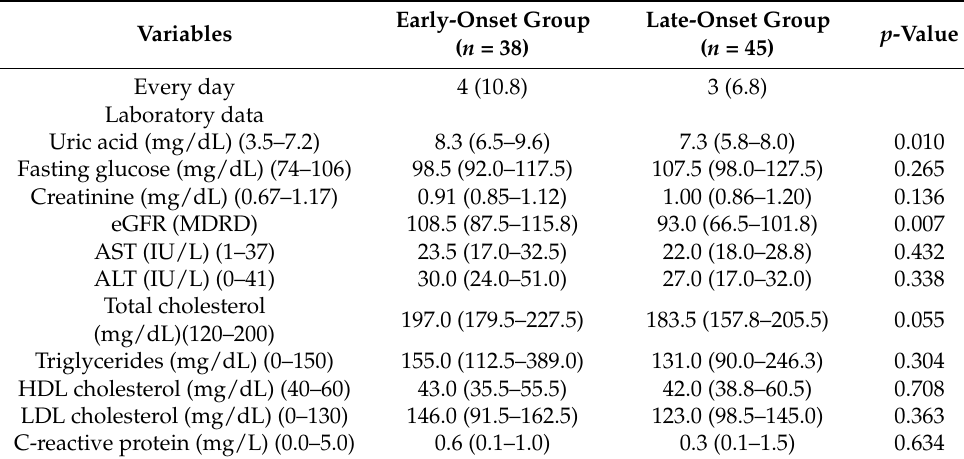
Continuous variables are shown as the median (interquartile range) and categorical variables as the number (percentage). ALT, alanine aminotransferase; AST, aspartate amniotransferase; eGFR, estimated glomerular filtration rate; LDL, low-density lipoprotein; HDL, high-density lipoprotein; MDRD, Modification of Diet in Renal Disease; SSB, sugar-sweetened beverages.